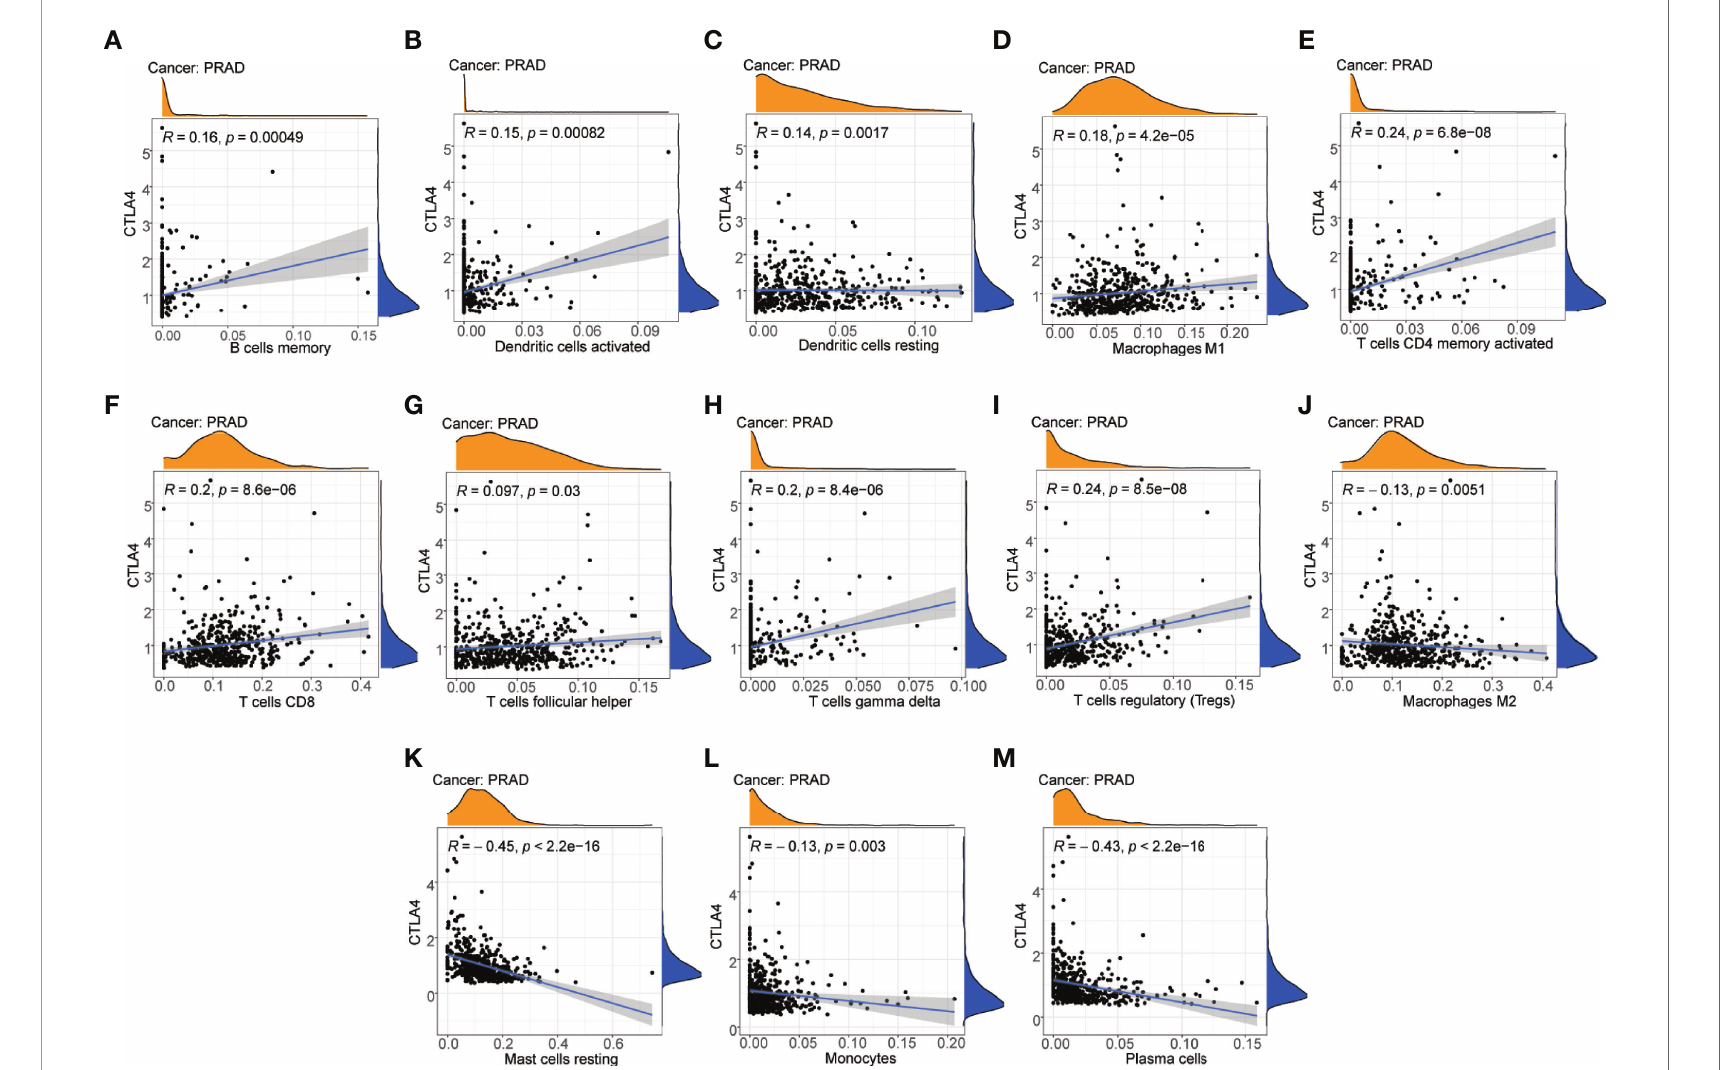
FIGURE 9 | Correlation between immune cell phenotypes and immune checkpoint gene CTLA4 . (A) Correlation between B cells memory and CTLA4 . (B) Correlation between dendritic cells activated and CTLA4 . (C) Correlation between dendritic cells resting and CTLA4 . (D) Correlation between macrophages M1 and CTLA4 . (E) Correlation between T-cell CD4 memory activated and CTLA4 . (F) Correlation between T-cell CD8 and CTLA4 . (G) Correlation between T cells follicular helper and CTLA4 . (H) Correlation between T cells gamma delta and CTLA4 . (I) Correlation between T cells regulatory (Tregs) and CTLA4 . (J) Correlation between macrophages M2 and CTLA4 . (K) Correlation between mast cells resting and CTLA4 . (L) Correlation between monocytes and CTLA4 . (M) Correlation between plasma cells and CTLA4